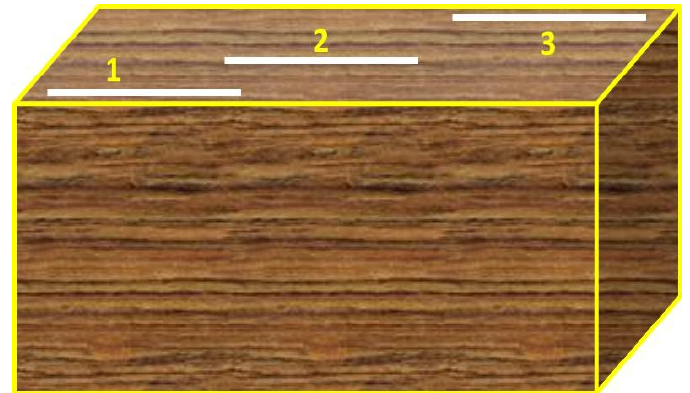
Figure 5. Measurement of surface roughness on the top surface at various positions.